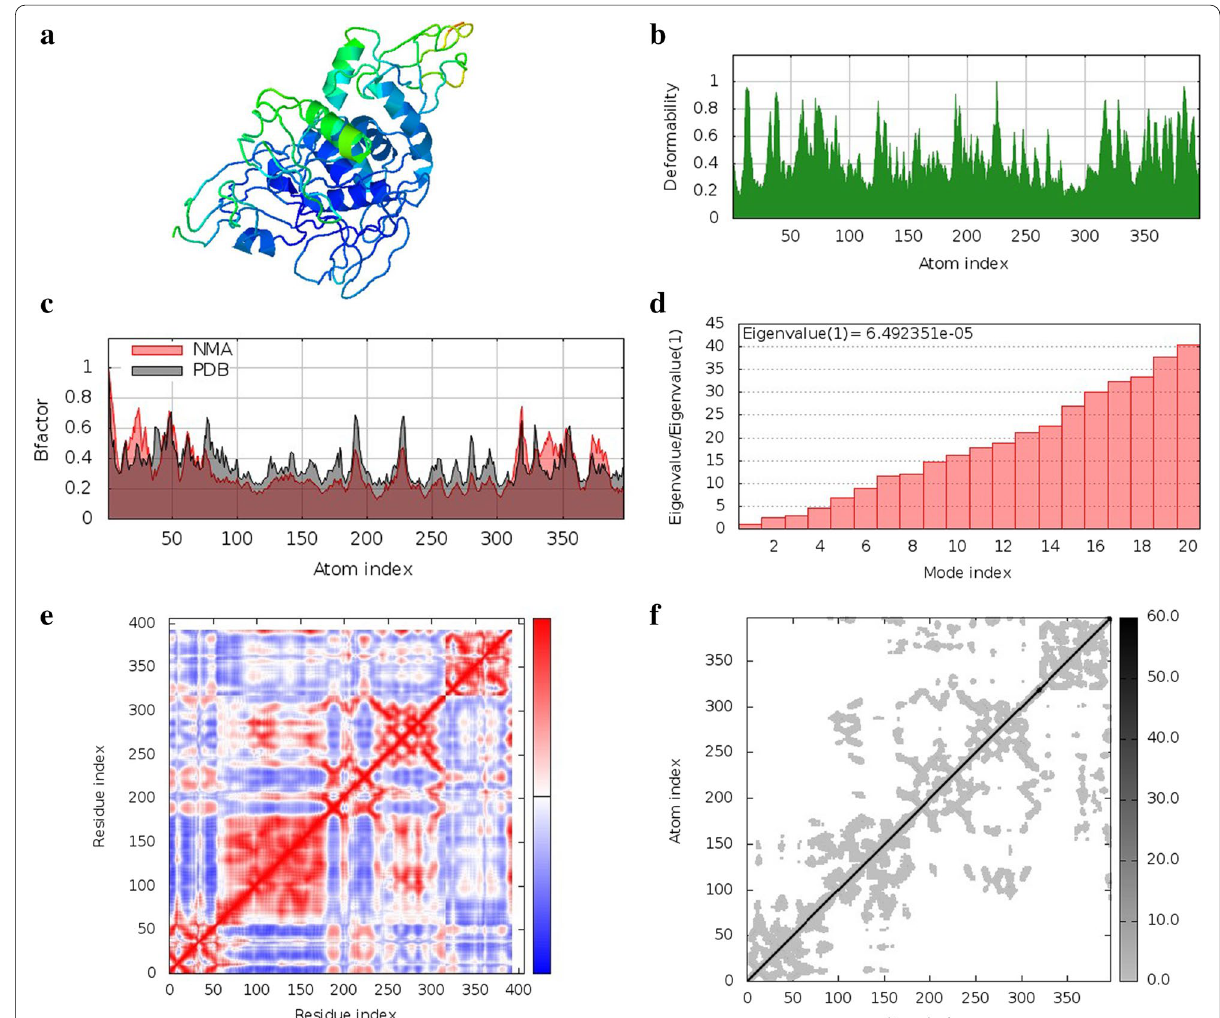
Fig. 7 Normal mode analysis of quercetin 3-O-arabinoside 7-O-rhamnoside and papain-like protease complex a NMA mobility, b deformity, c B-factor, d eigenvalues, e covariance map, f elastic network of